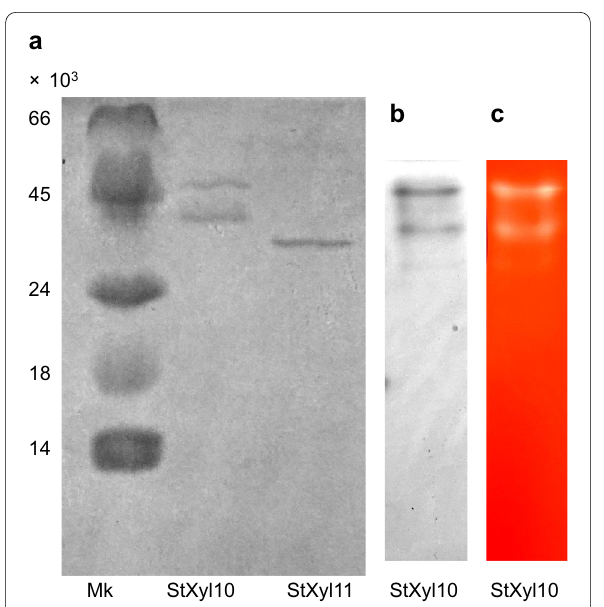
Fig. 1 SDS-PAGE and native-PAGE of purified xylanases. a SDS-PAGE was performed on a 15% acrylamide gel, and 1 μg of the purified enzymes was applied. b CBB staining of native-PAGE of 2 μg of purified StXyl10. c Congo red staining of agar plates containing 0.5% GX hybridized with native-PAGE